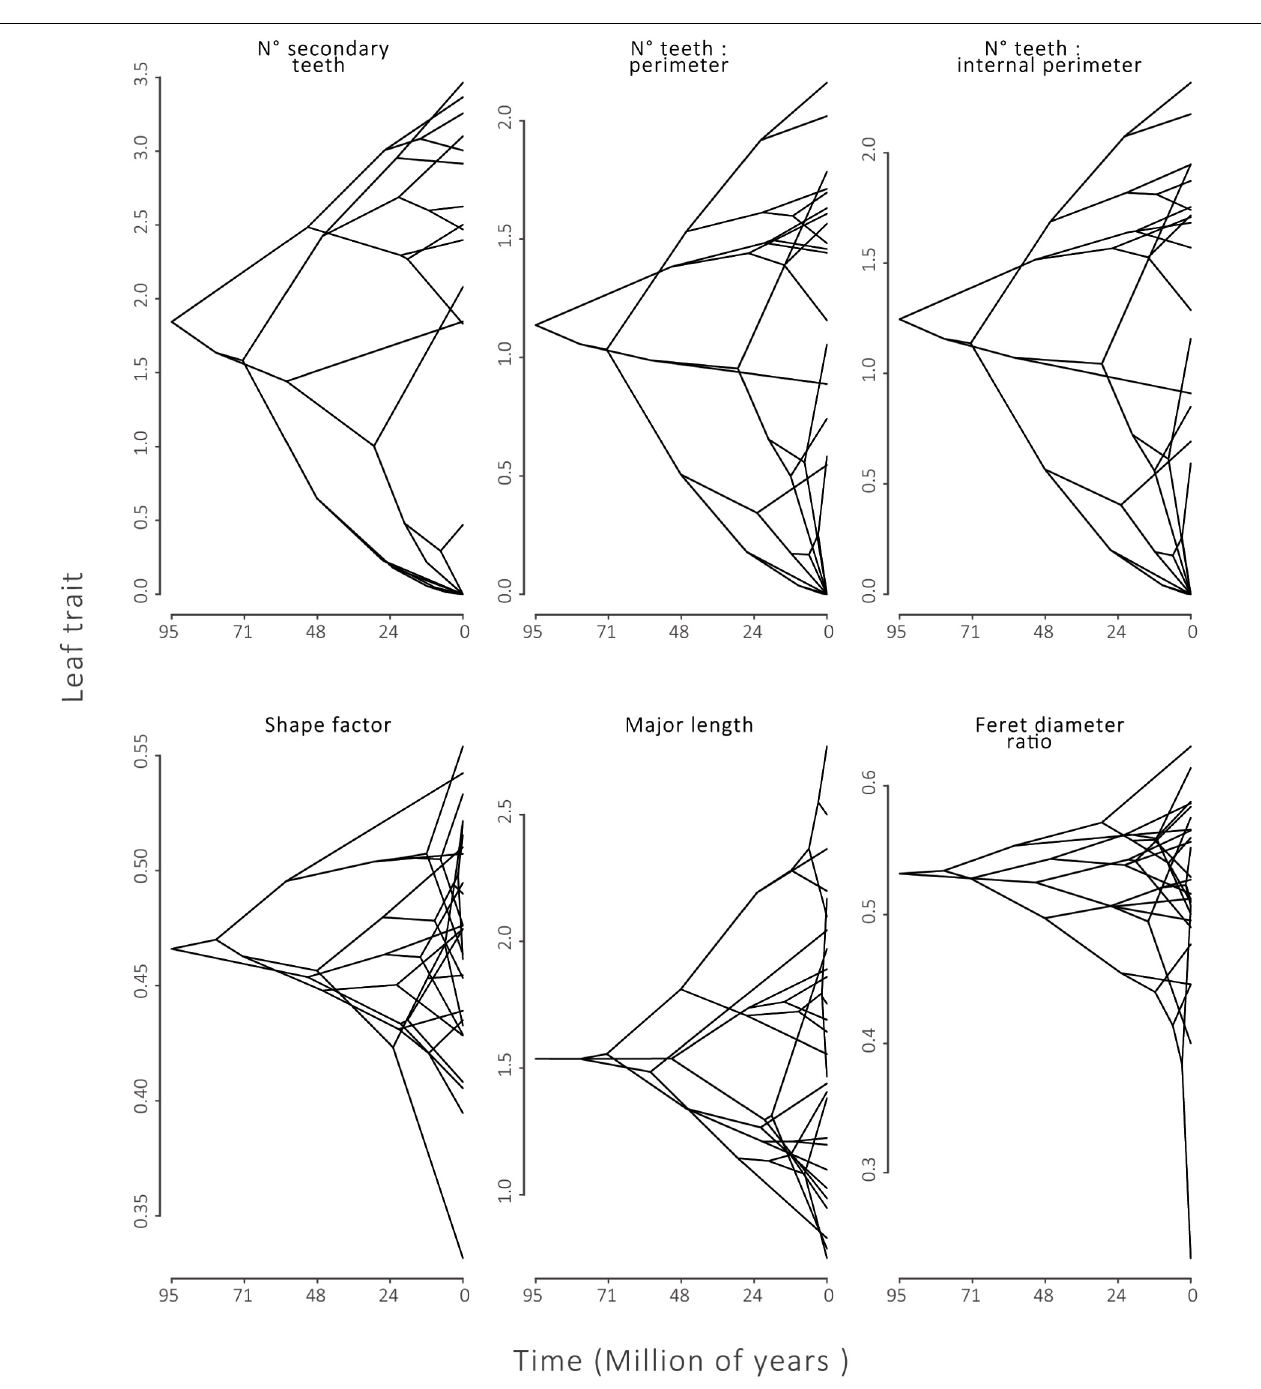
FIGURE 3 | Phylogenetic Traitgrams for leaf traits with strong phylogenetic signal:number of secondary teeth (2 ◦ teeth), number of teeth:perimeter and number of teeth:internal perimeter. And for traits that did not present phylogenetic signal: shape factor, minor axis length, Feret diameter. Tips of phylogenies along the Y -axis show species trait values. The X -axis defines time of divergence from the common ancestor of Nothofagaceae.